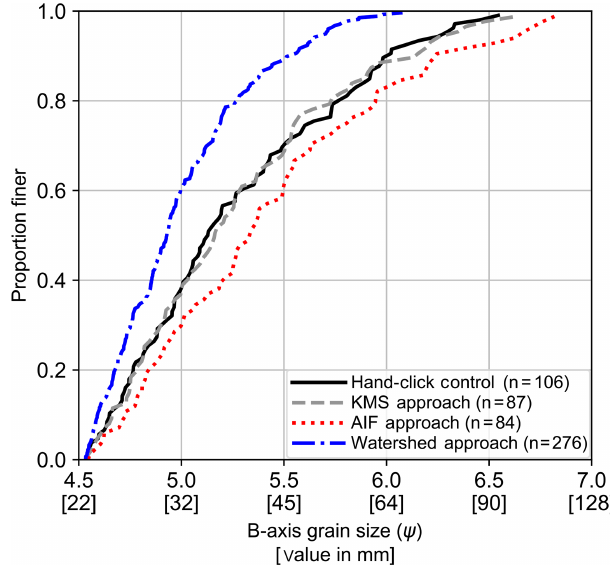
Figure 2. Watershed segmentation (blue, dashed and dotted line) versus KMS (gray, dashed line) and AIF (red, dotted line) ap- proaches compared with a hand-clicked b -axis grain-size distribu- tion (black line) for a ∼ 1m 2 river patch (S09 in Fig. 6b). Watershed approach leads to oversegmentation of grains, giving an unreason- able number of clasts (276 versus 106 in the control) and an overly fine grain-size